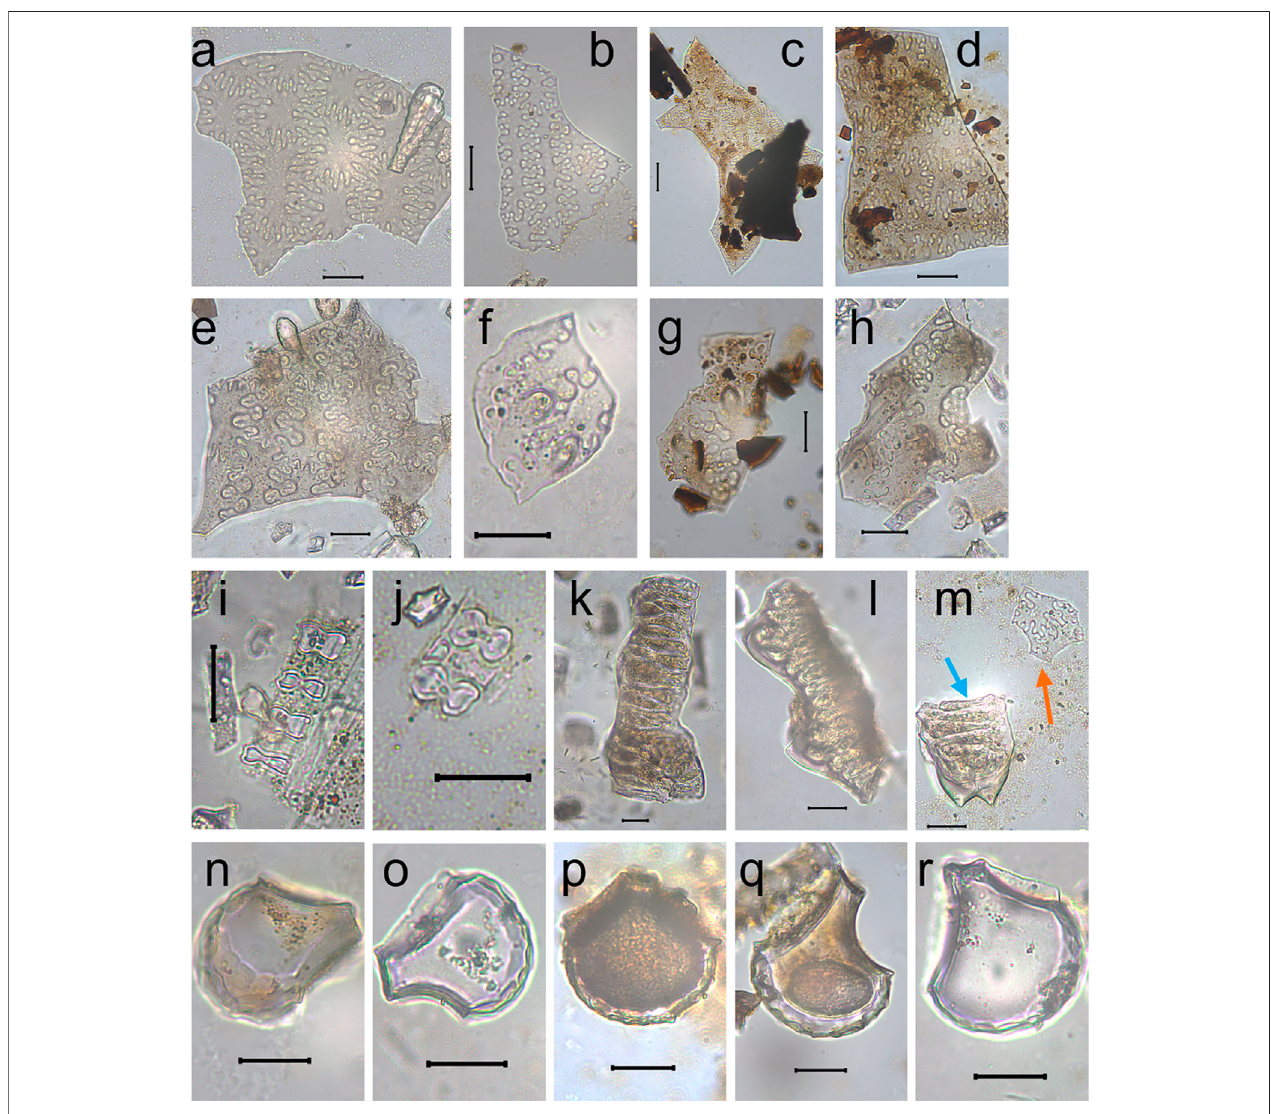
FIGURE 2 | Crop phytoliths obtained from the Guijiabao site. (A – D) : broomcorn millet η -type; (E – H) : foxtail millet Ω -type; (I,J) : rice parallel bilobate; (K,L) : rice double-peaked; (M) :ricedouble-peaked(bluearrow)andbroomcornmillet η -type(orangearrow); (N,O) :ricebulliformwith < 9scales; (P – R) :ricebulliformwith ≥ 9scales (scale bar = 20 μ